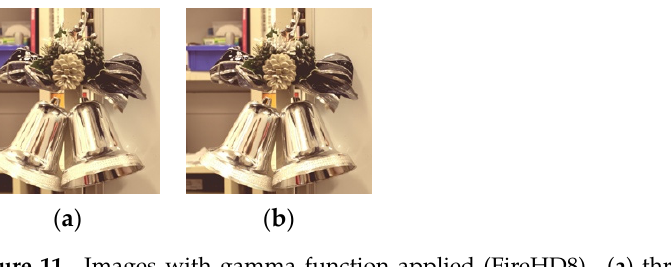
Figure 11. Images with gamma function applied (FireHD8). ( a ) threshold: 0.9 parameter: 1.5; ( b ) threshold:0.9 parameter: 0.5.